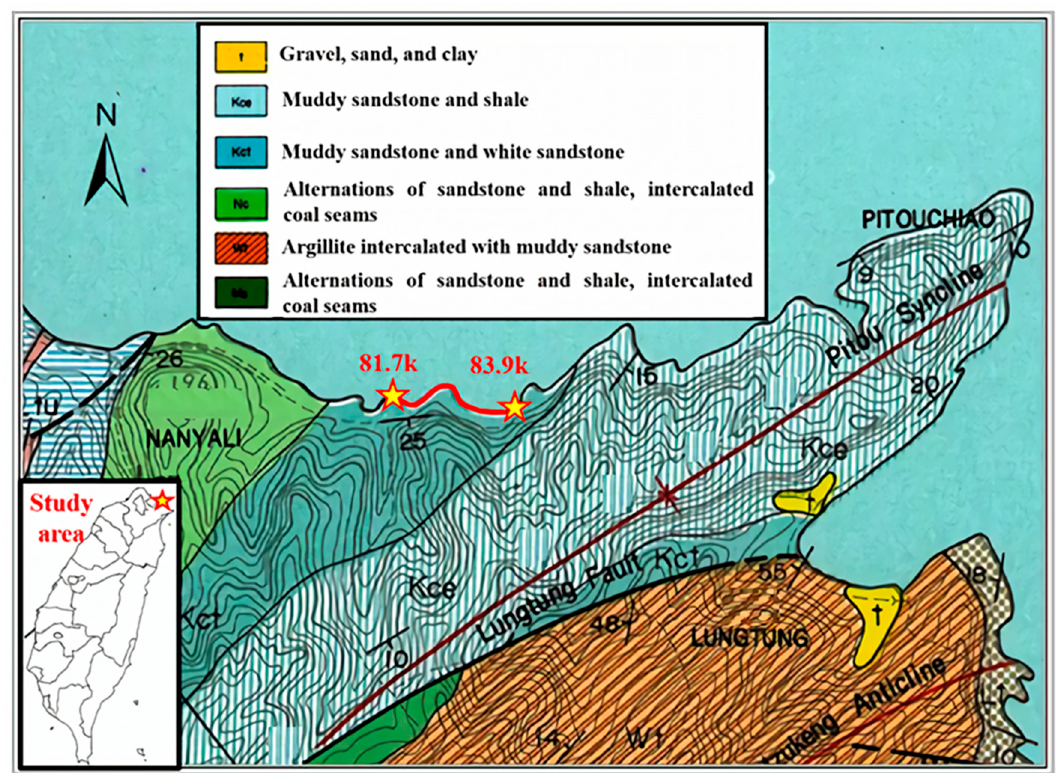
Figure 1. The 1/50,000-scale geological map of the study area.